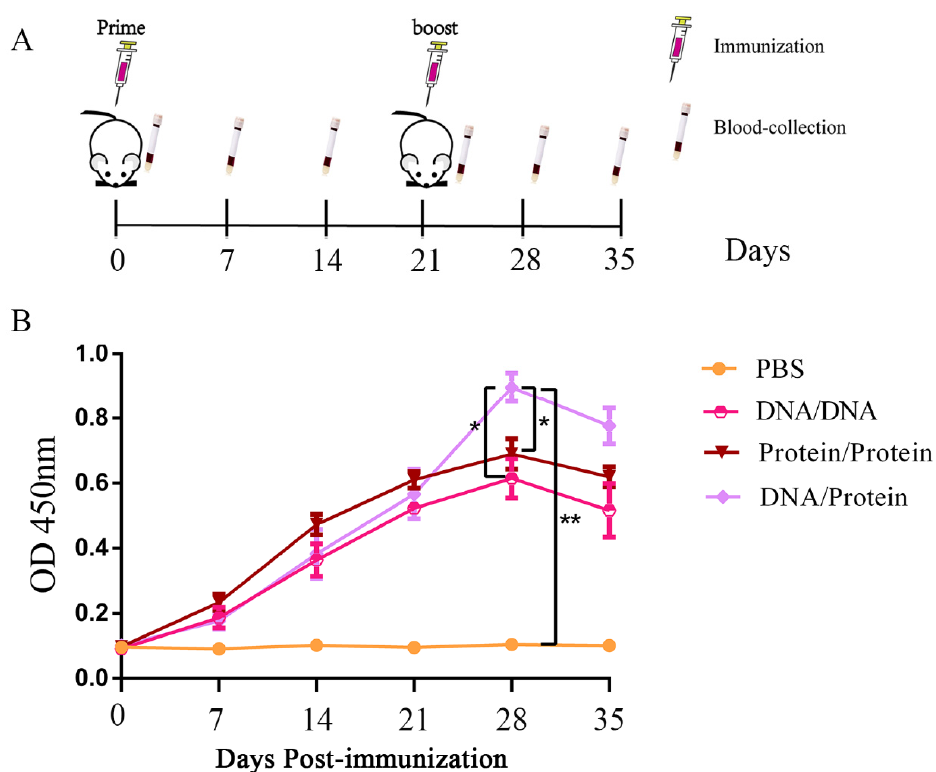
Figure 3. Specific antibody levels in mice immunized with different vaccines. ( A ) Vaccination and blood collection schedule. ( B ) The mouse serum on days 0, 7, 14, 21, 28, and 35 after immunization was collected and inactivated at 56 °C for 30 min. The level of specific IgG in the mice was assessed by indirect ELISA with the purified B2L and cF1L proteins. Data are expressed as mean ± standard error ( n = 10). OD 450nm , optical density at 450 nm, * p < 0.05 and ** p < 0.01.